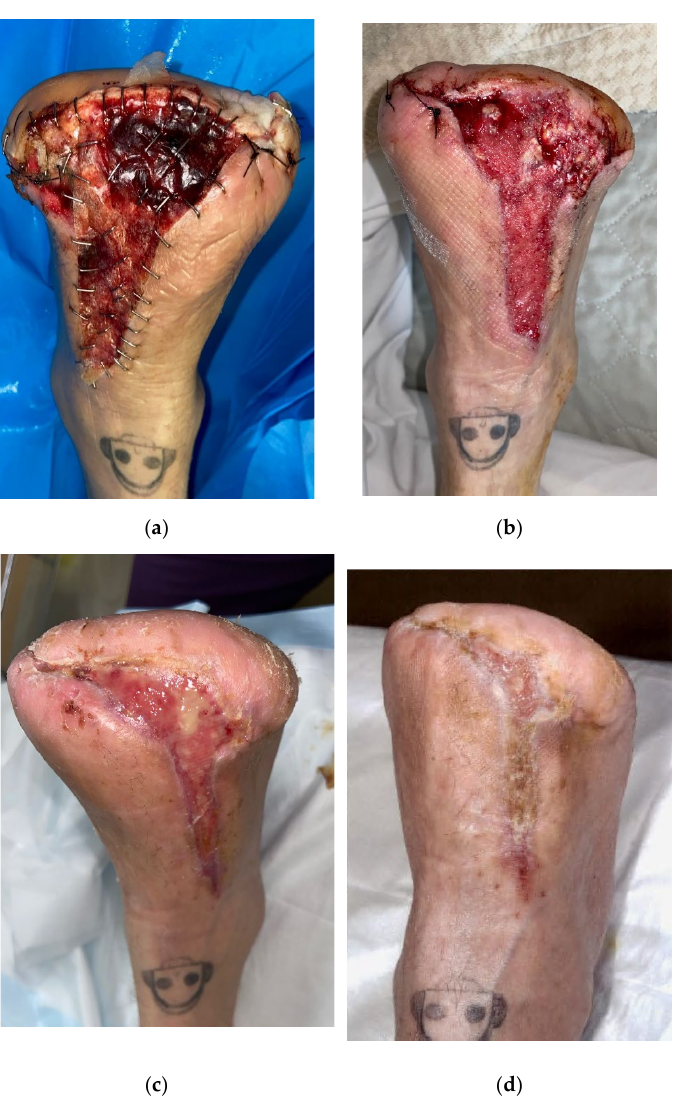
Figure 2. ( a ) Left forefoot amputation wound, day 28 post-transmetatarsal amputation, day 10 post- BTM application; ( b ) day 24 post-BTM application, sealing membrane removed to reveal healthy granulation tissue; ( c ) day 45 post-BTM application, contraction of wound bed and advancing epithelial margins; ( d ) day 55 post-BTM application, significant surface area reduction, only small area of open wound bed remains .